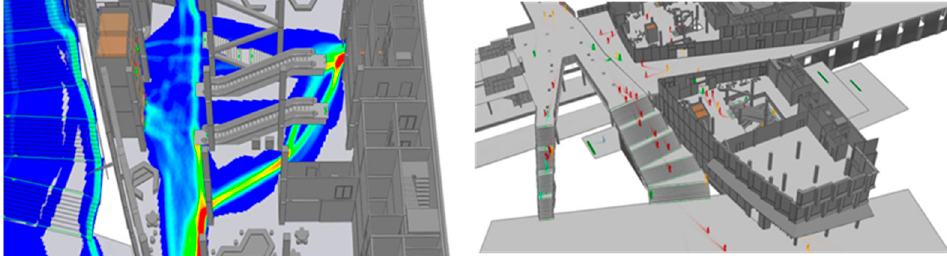
Figure 13. MassMotion applications in 3D complex environments.